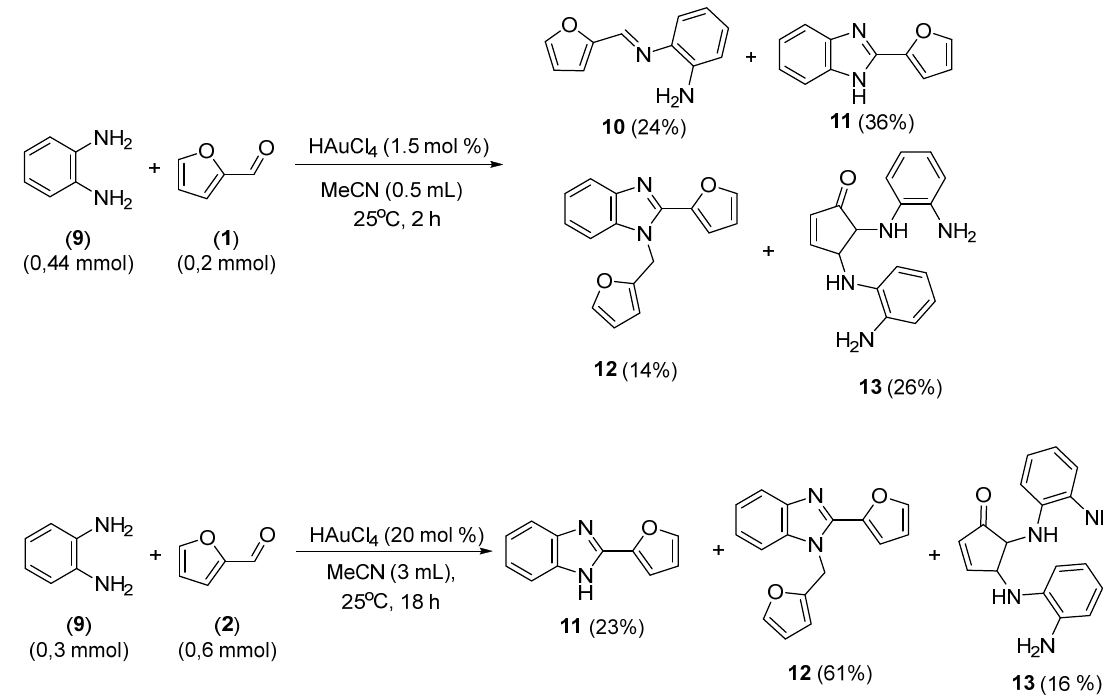
Scheme 5. Reaction between o -phenylenediamine and furfural mediated by HAuCl 4.